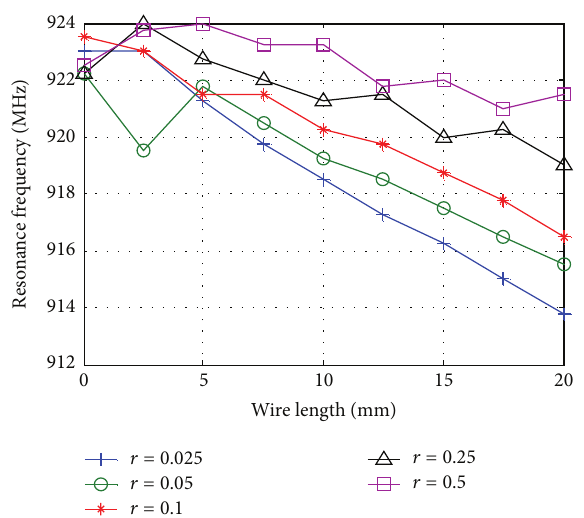
Figure 11: Simulated resonance frequency for different wire lengths 𝑙 and radius 𝑟 .